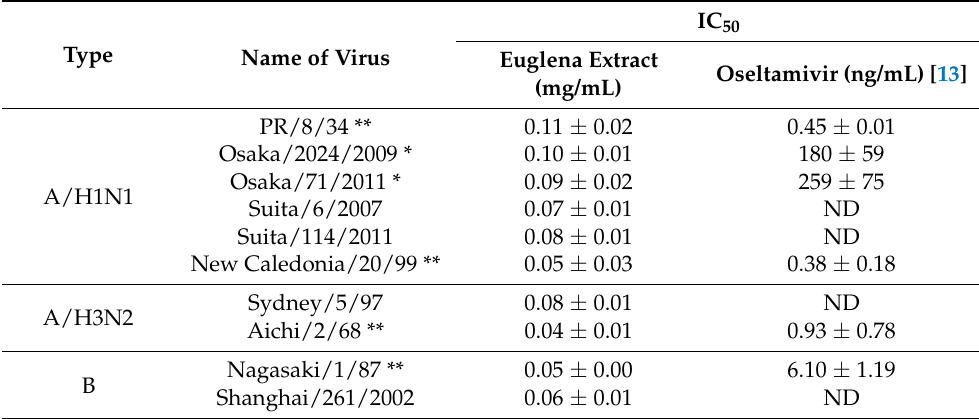
Table 1. Effect of Euglena extract on the infection of various types of influenza viruses.